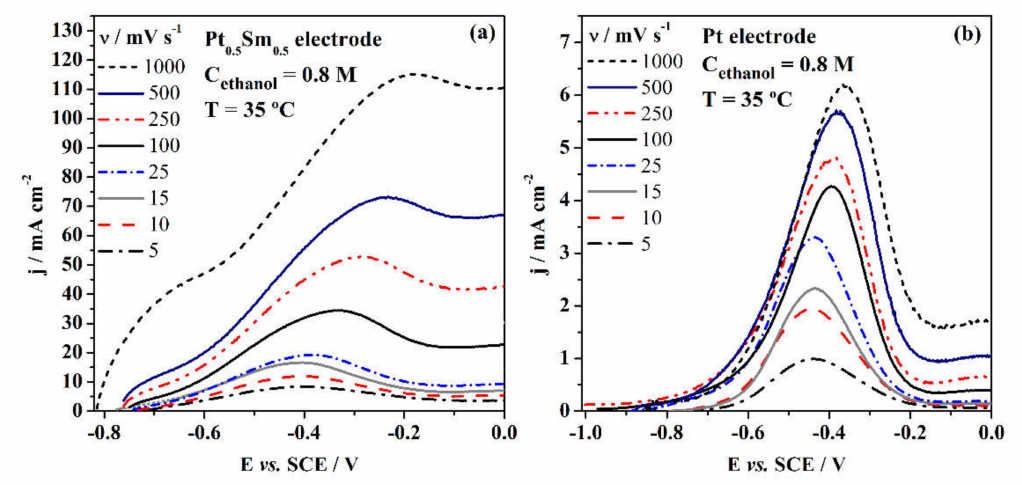
Figure 4. Anodic polarization curves of ( a ) Pt 0.5 Sm 0.5 electrode and ( b ) Pt electrode in 0.8 M ethanol + 2 M NaOH, at 35 ◦ C, for ν ranging from 5 to 1000 mV s − 1 .